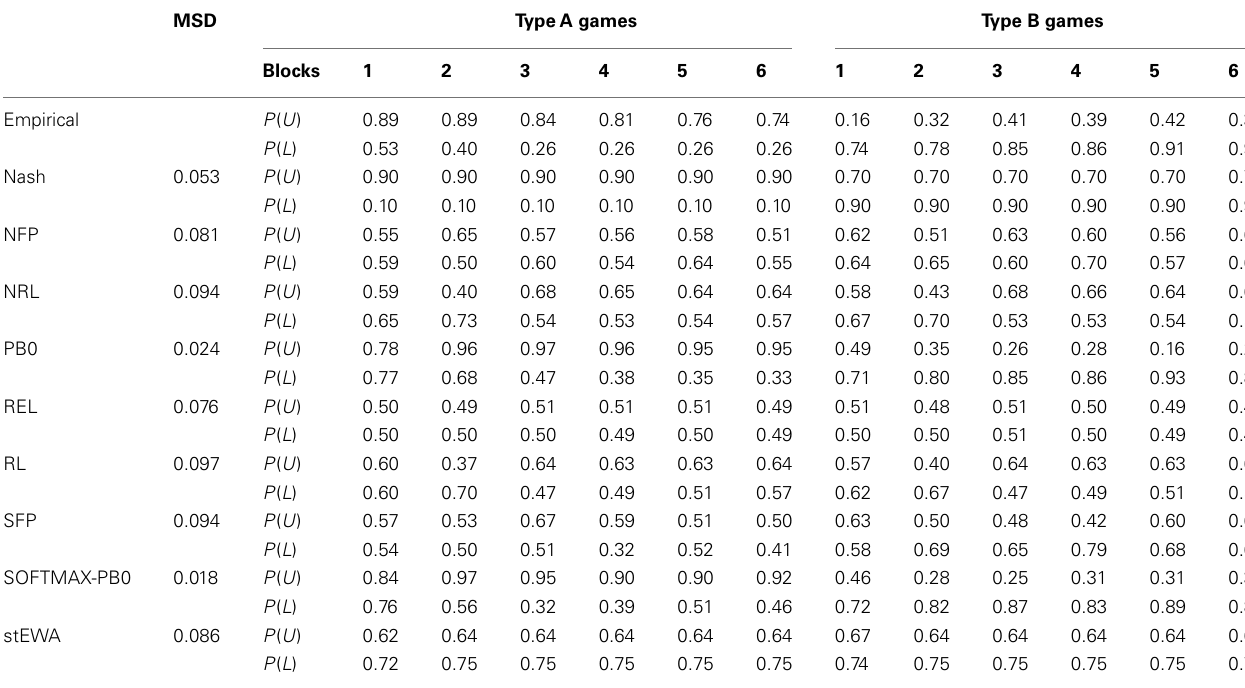
Table 3 | Predicted and observed choice frequencies in Experiment